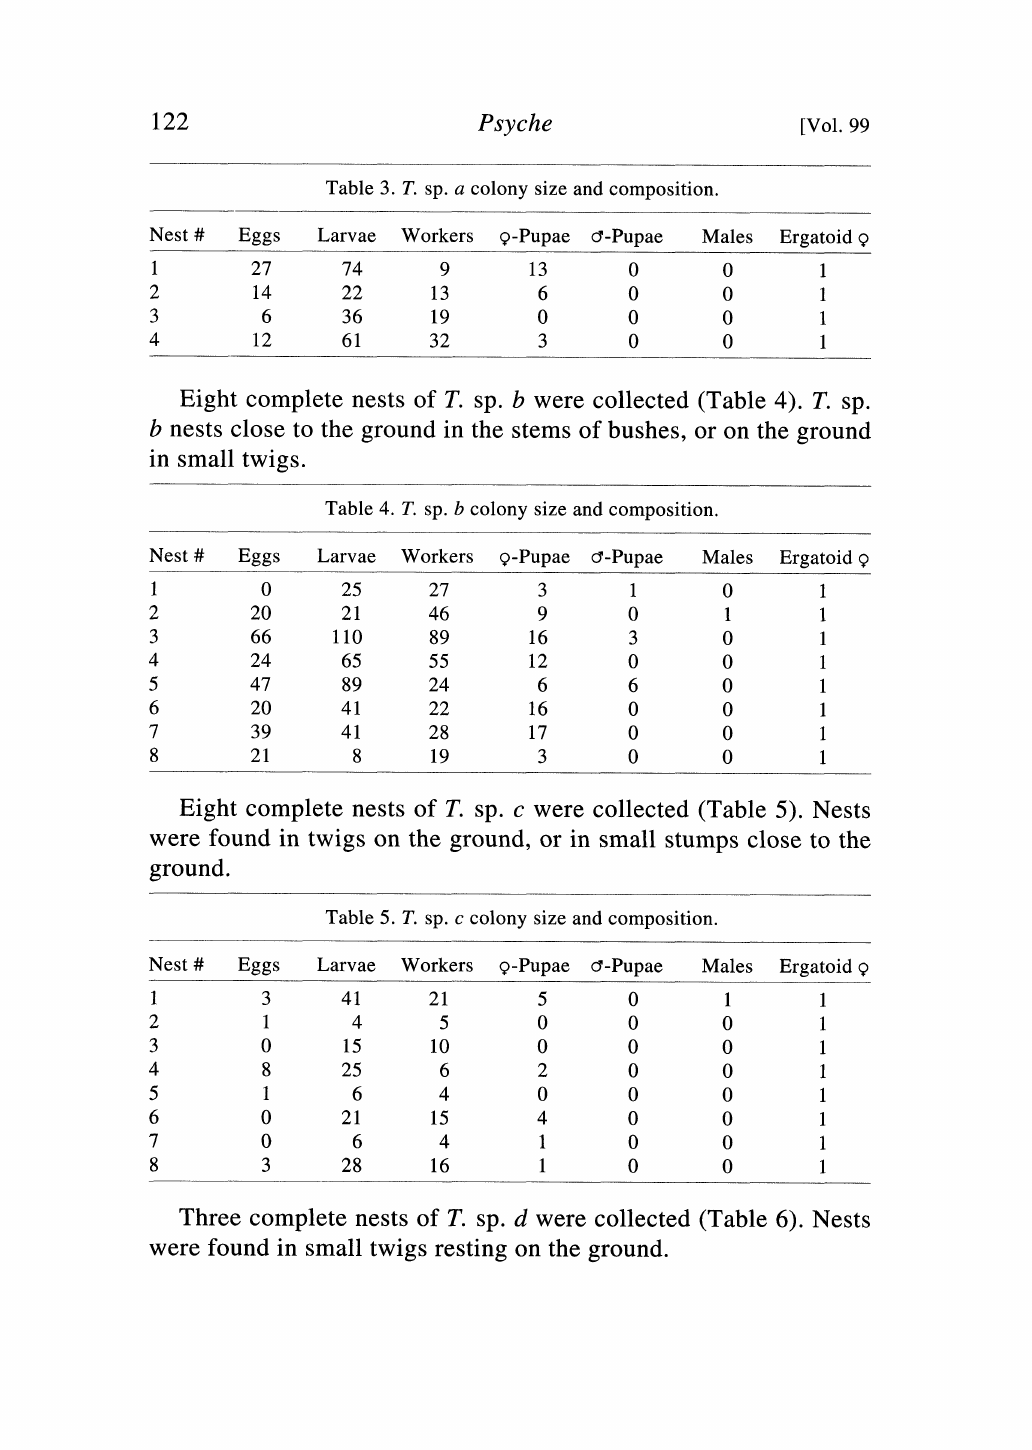
Table 3. T. sp. a colony size and composition.